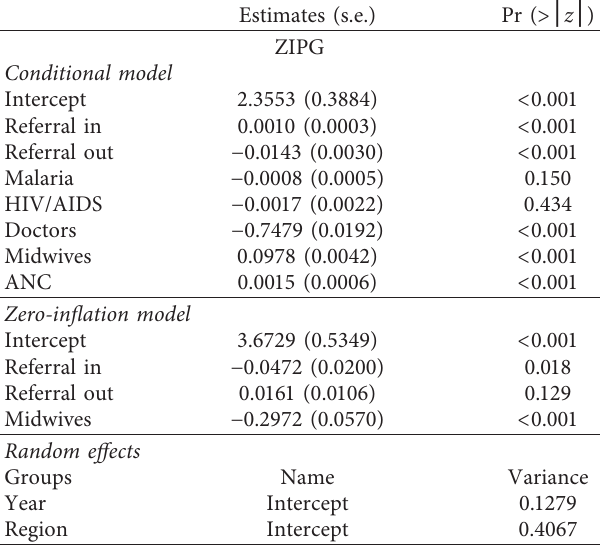
Table 3: Maternal mortality data. Parameter estimates and stan- dard errors (s.e.) for the zero-inflated Poisson GLMM (ZIPG). Estimates